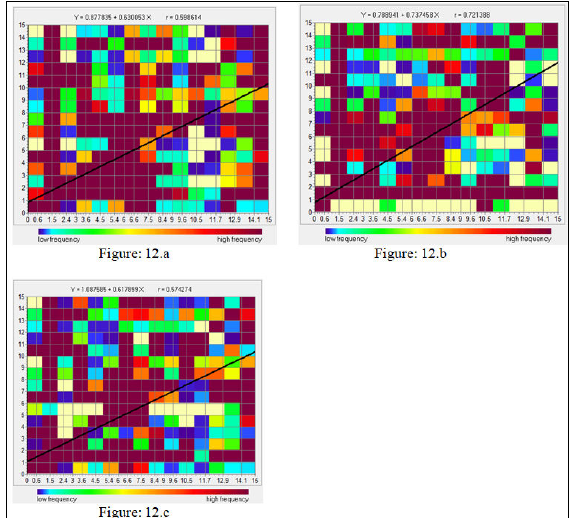
Figure 12.a. Relationships between predicted LULC of 2050 using 1987 & 1997 LULC image and predicted LULC of 2050 using 1997 & 2007 LULC image; Figure 12.b. Relationships between predicted LULC of 2050 using 1997 & 2007 LULC image and predicted LULC of 2050 using 1987 & 2007 LULC image; Figure 12.c. Relationships between predicted LULC of 2050 using 1987 & 1997 LULC image and predicted LULC of 2050 using 1987 & 2007 In all the above three cases i.e., location predicted LULC of 2017, 2027, 2050 show positive but weak correlation (Table 6).